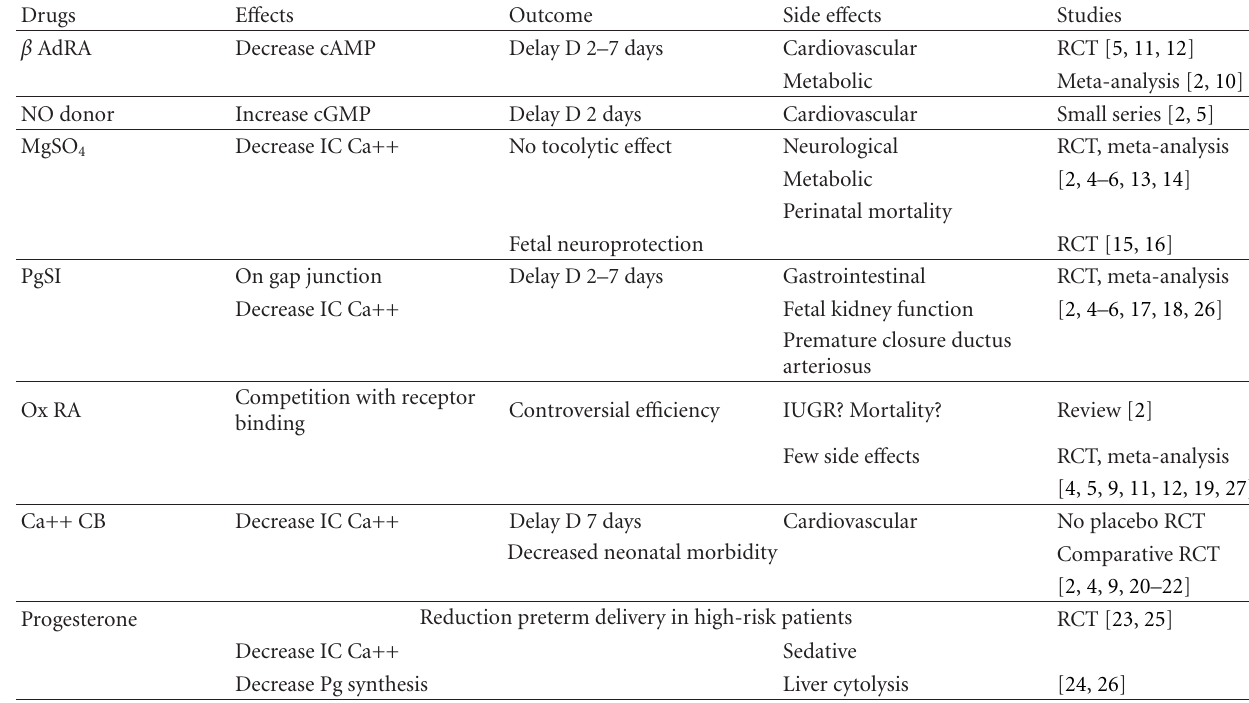
Table 1: E ff ects of currently used tocolytic